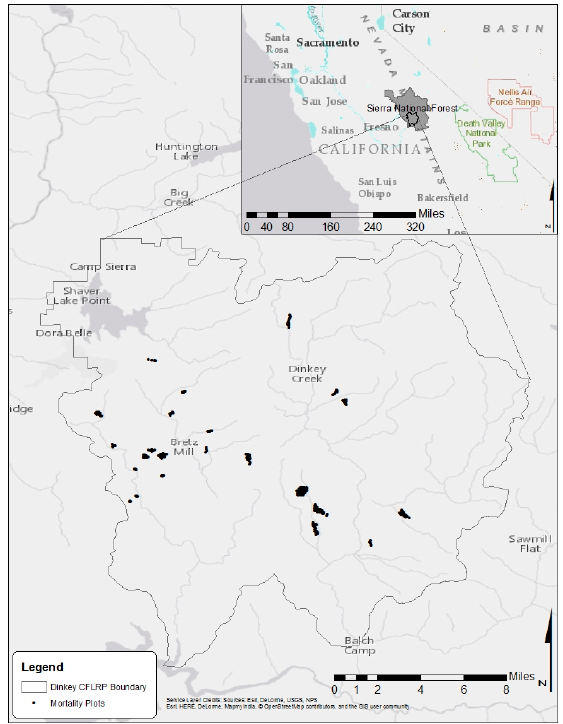
Figure 1. Map of the 255 mortality plot locations measured four times from 2015 through 2017